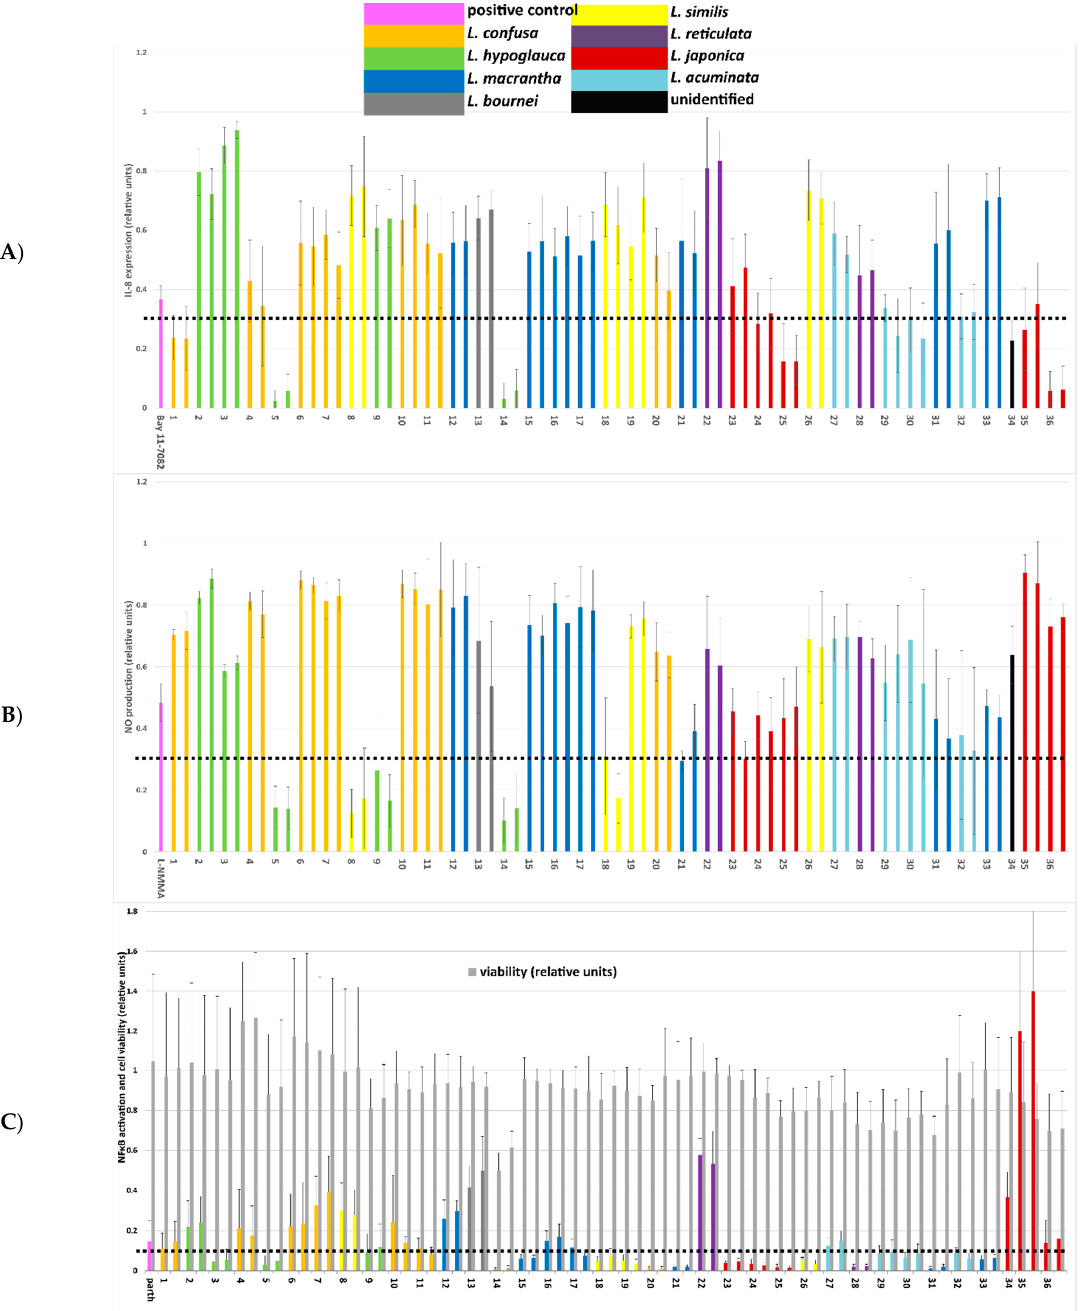
Figure 2. Results of activity testing of Lonicera ethanolic leaf extracts 1–36 (colored according to species) on the production of inflammation mediators. ( A ) Effect on IL-8 expression in HUVECtert cells stimulated with LPS. Extract concentration: 50 µg/mL; positive control: Bay 11-7082 (7.5 µM); results are given as the means ± SD of 6 replicates. ( B ) Effect on NO production in LPS/IFN γ - stimulated RAW macrophages. Extract concentration: 50 µg/mL; Positive control: L-NMMA (100 µM); results are given as the means ± SD of three experiments performed in duplicates. ( C ) Effect on NF- κ B transactivation and on cell viability in HEK/NF κ B-luc cells stimulated with TNF- α ; extract concentration: 50 µg/mL; positive control: parthenolide (5 µM). Results are given as the means ± SD of 4 replicates (each in quadruplicate).